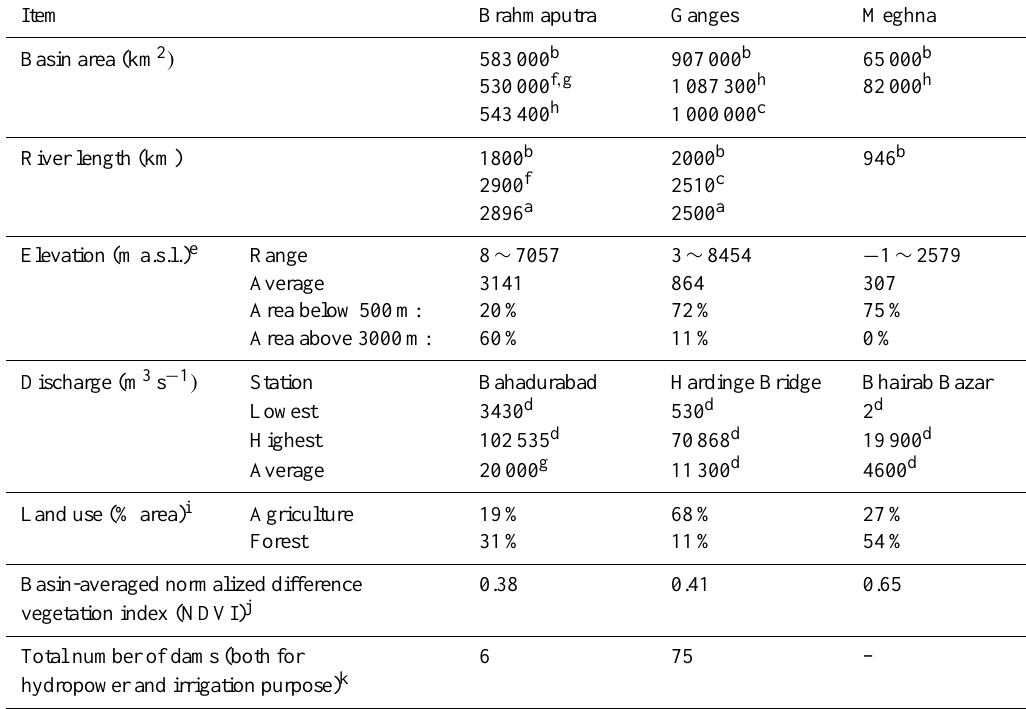
Table 1. Major characteristics of the Ganges, Brahmaputra and Meghna river basins.